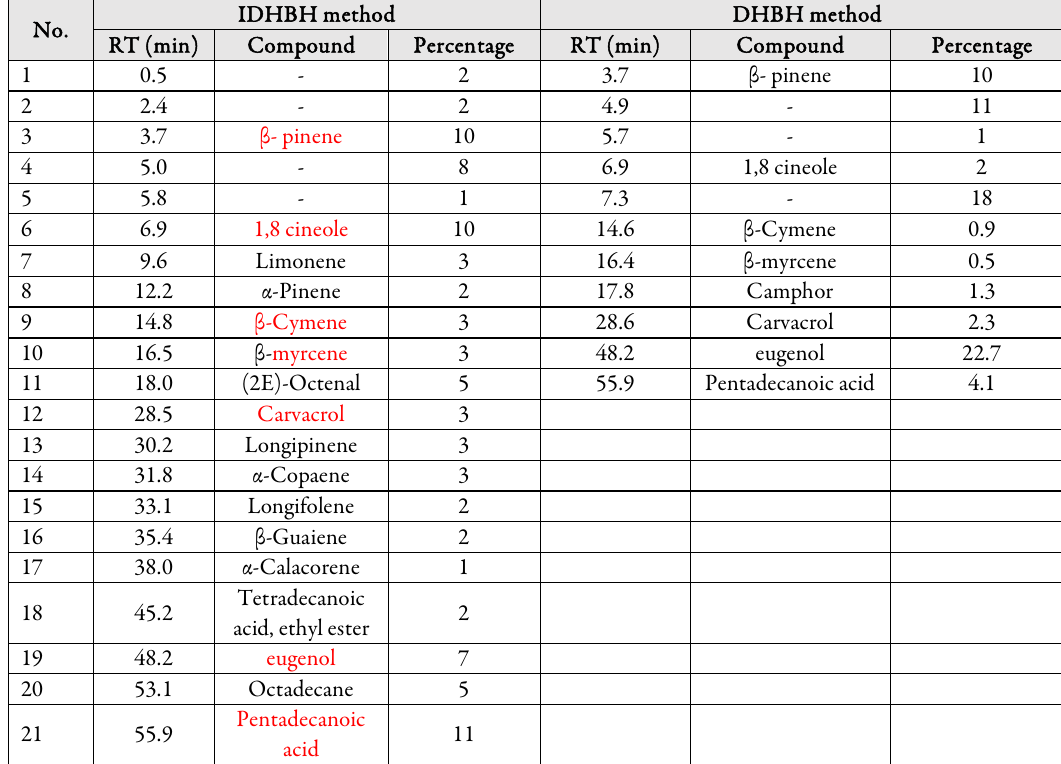
Table 3. Chemical profile of bioactives in dark and light oils of eucalyptus